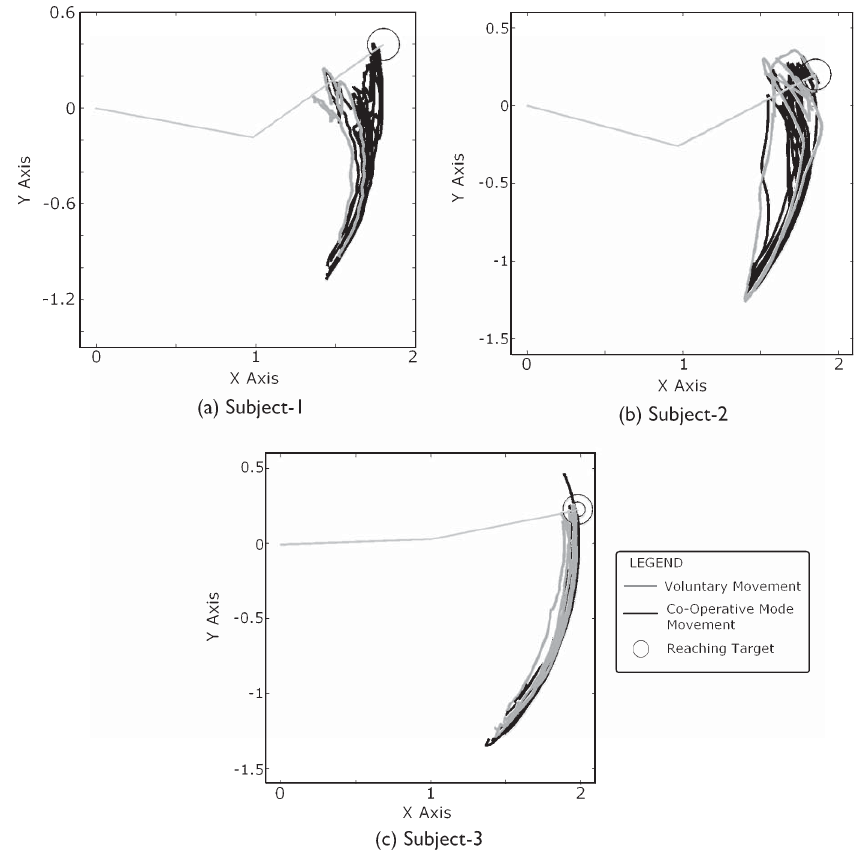
Fig. 7. Endpoint trajectory for ACM reaching movements to Target-2 for the three stroke